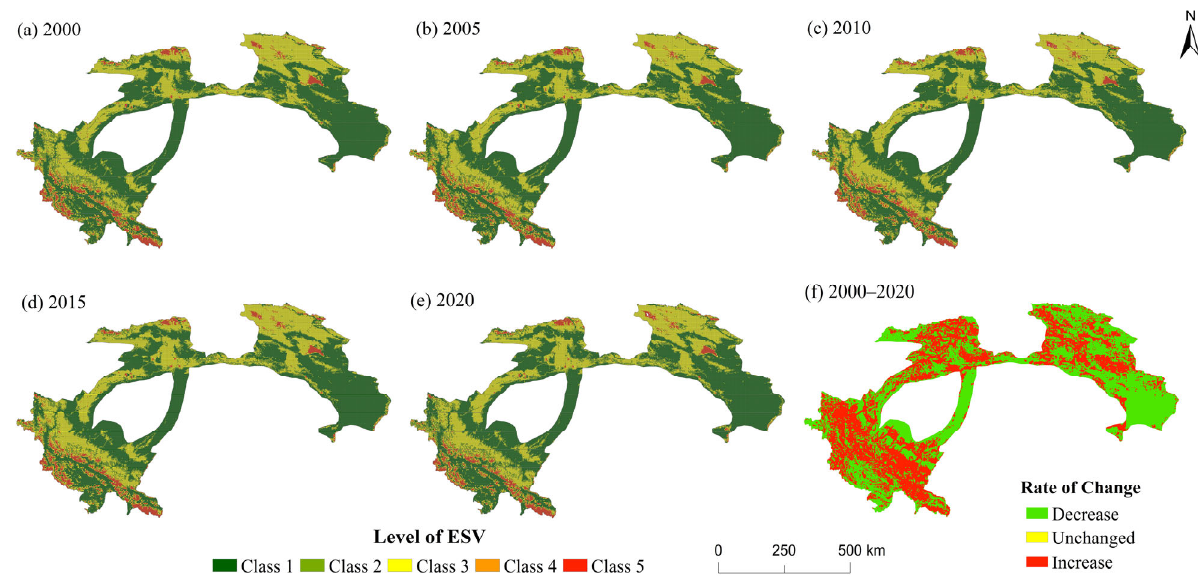
Figure 3. Changes in ESV distribution in the TRB during 2000 – 2020. ( a – e ) show the spatial distribu ‐ tion characteristics of ESV classes every five years, while ( f ) shows the change characteristics of